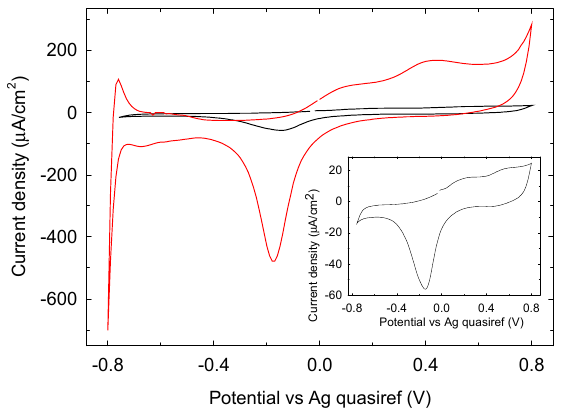
Figure 5. Cyclic voltammetry on untreated Pt SPE (black trace) and with phosphate buffer 0.1 M LIFT treated Pt SPE (red trace) in phosphate buffer 90 mM pH 7.0, scan rate 50 mV/s. Inset: zoom view of untreated Pt SPE.